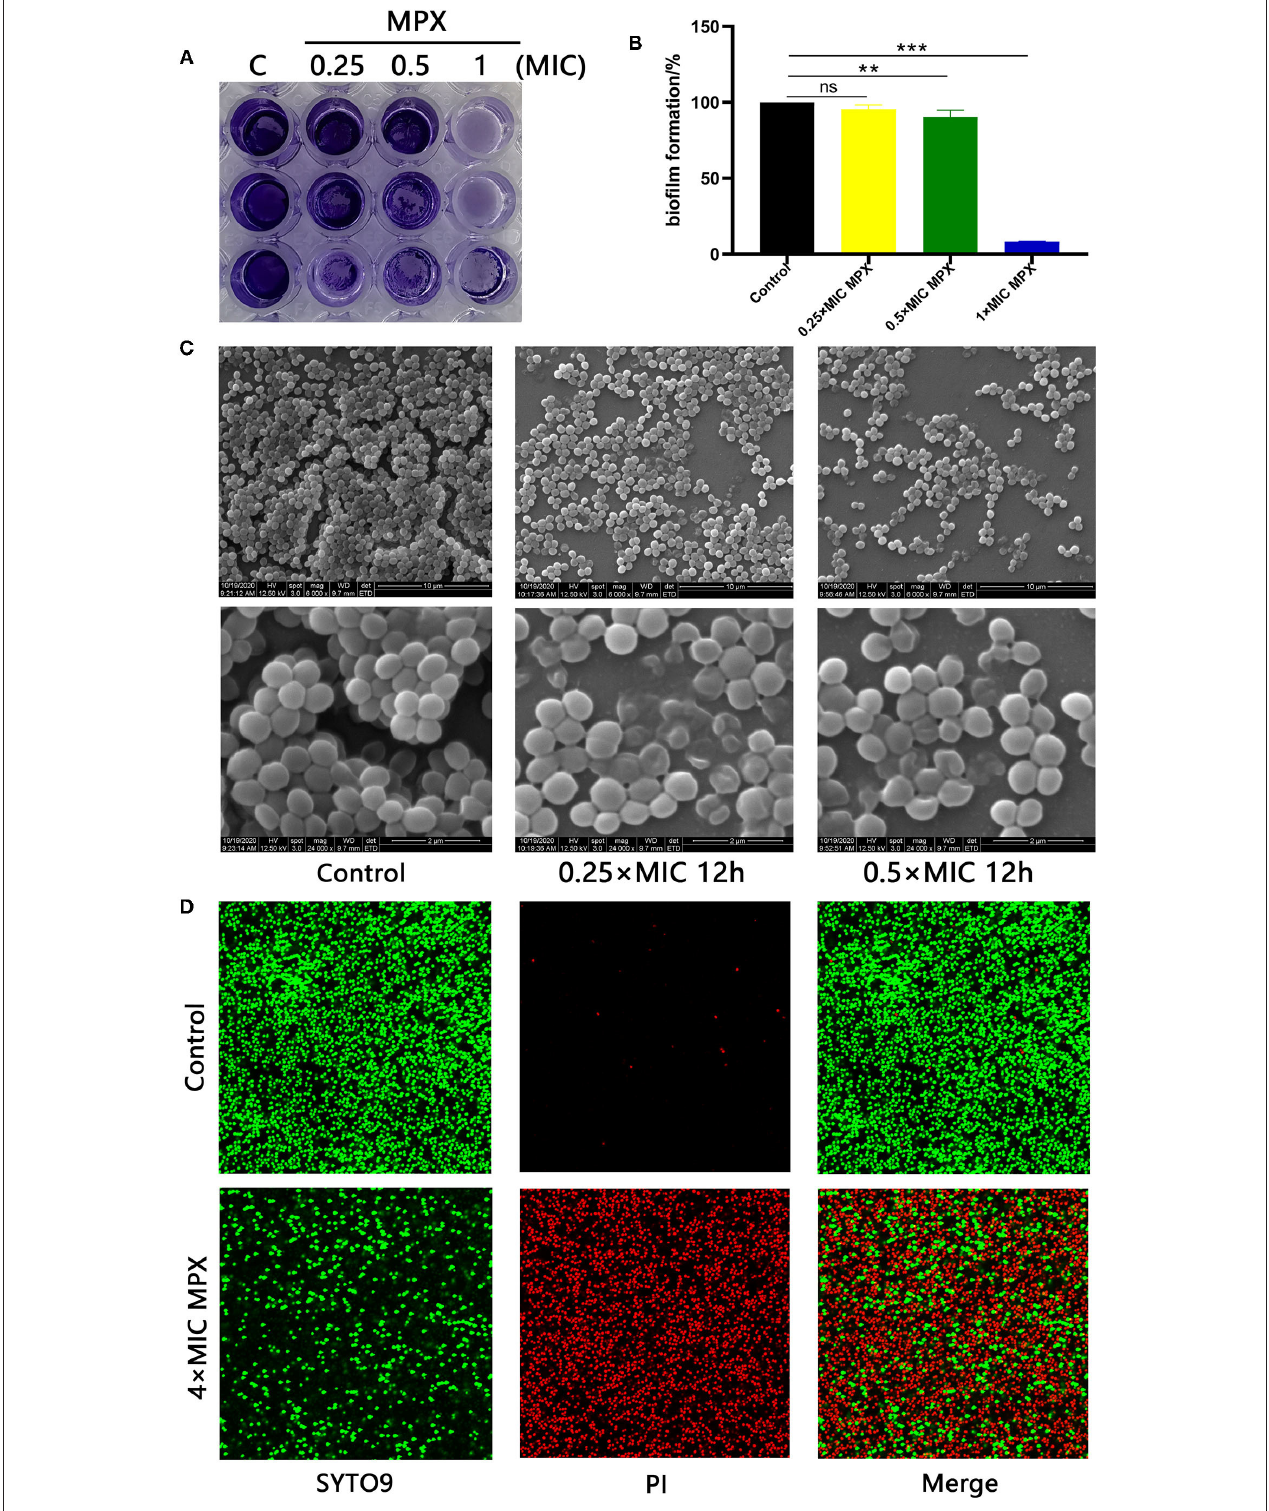
FIGURE 4 | MPX inhibits biofilm formation. (A) The results of crystal violet staining of biofilms after different concentrations of MPX were applied to S. aureus ATCC 25923. (B) OD 570 measurement after crystal violet was dissolved in 70% ethanol. (C) After exposure of S. aureus ATCC 25923 to different concentrations of MPX, scanning electron microscopy was used to observe the biofilm. (D) The results of staining S. aureus with SYTO 9/propidium iodide. Error bars indicate the mean ± SEM, n = 3. Statistical significance was defined as follows: ** p < 0.01; *** P < 0.001; ns P > 0.05.